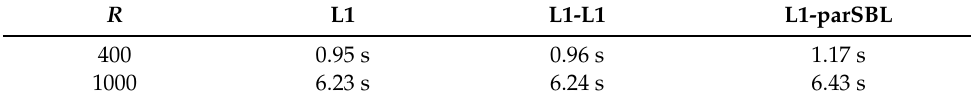
Table 1. Computational times based on 50 independent trials.